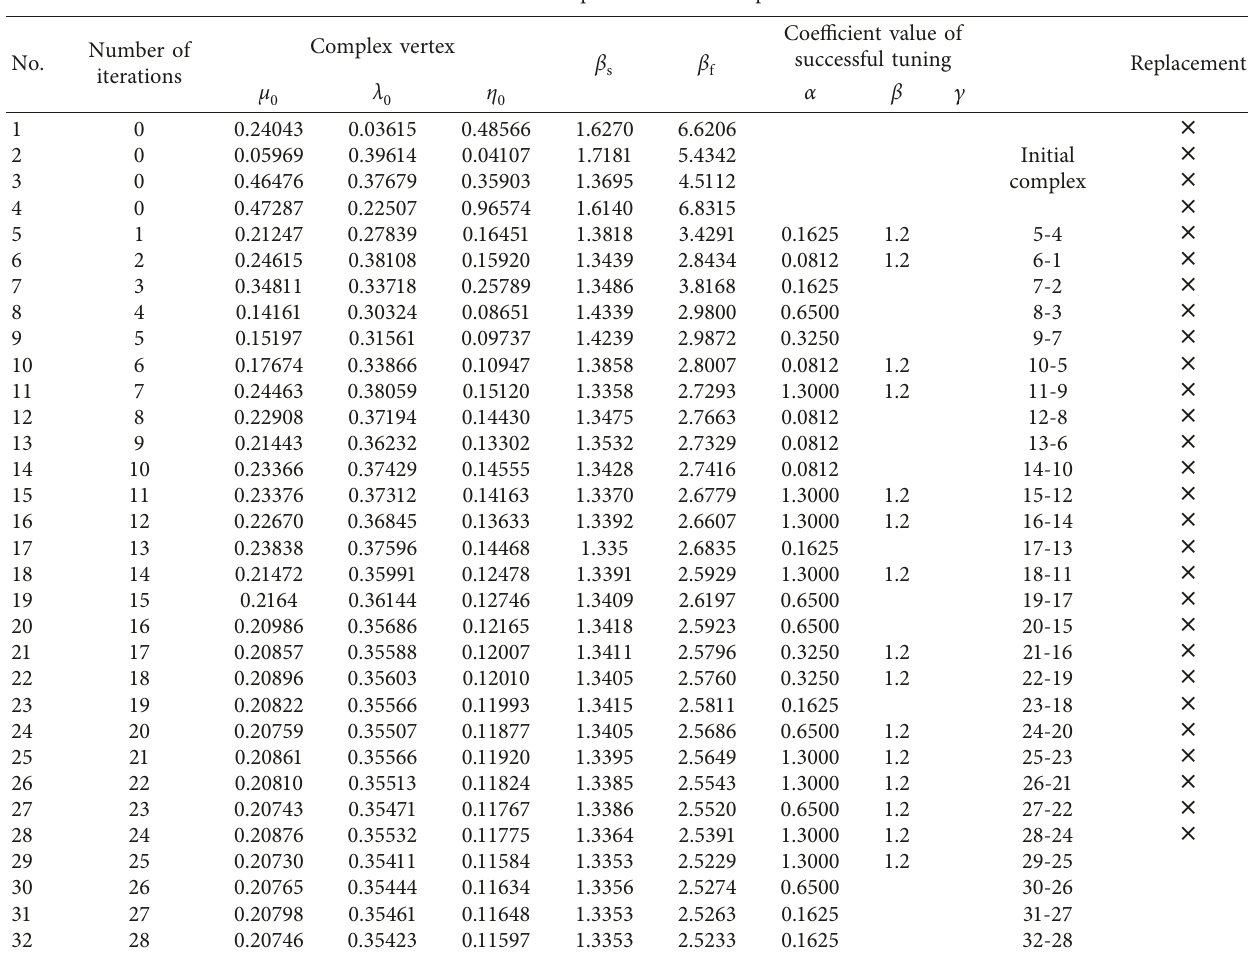
Table 3: Calculation process of the complex